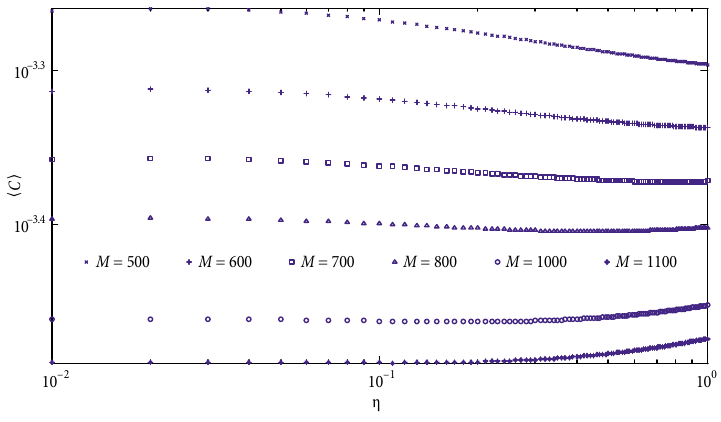
where b = 0.4 and q = i i